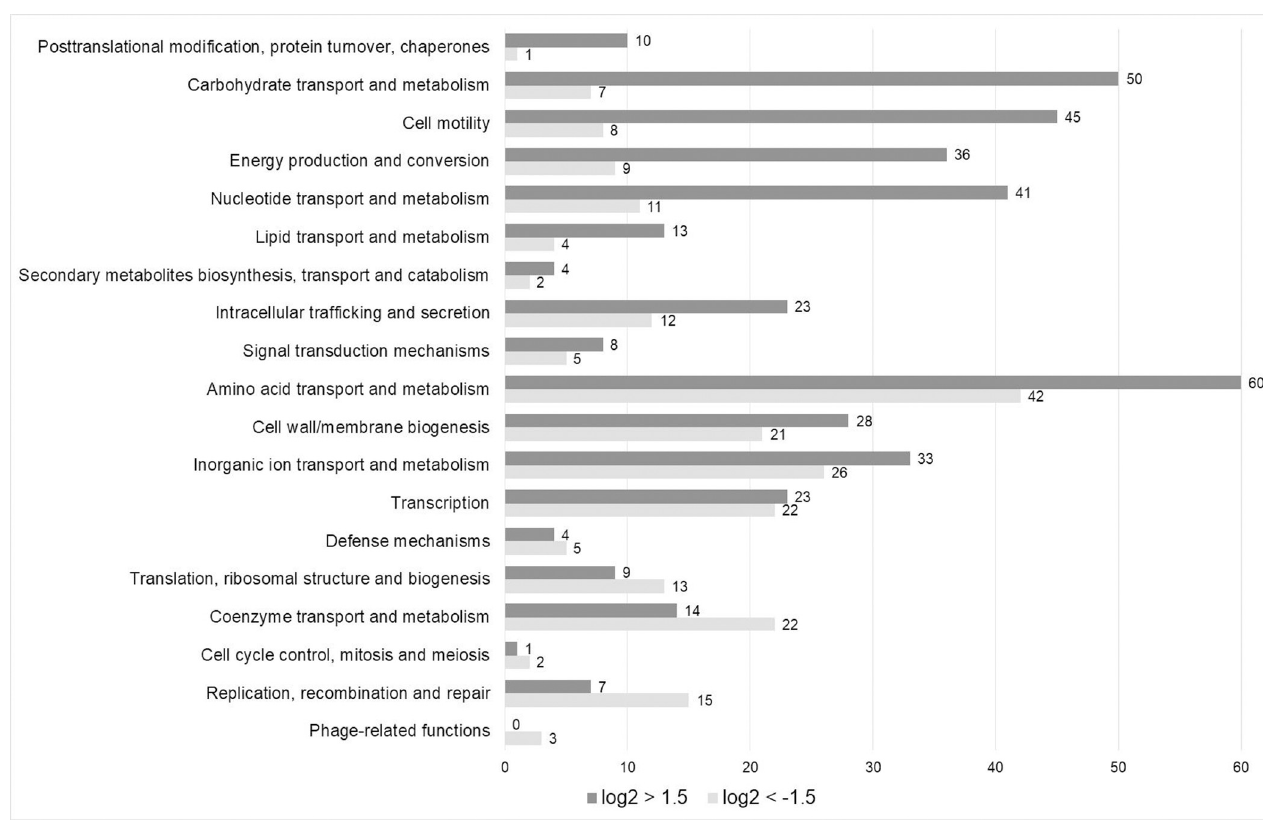
Fig 8. COG categories of differentially expressed W22703 genes upon G . mellonella infection. The numbers of down-regulated (light grey) and up- regulated (dark grey) genes in each COG category are indicated. The COG categories are ordered by descending ratio of up-to down-regulated genes. The data were taken from S1 Table